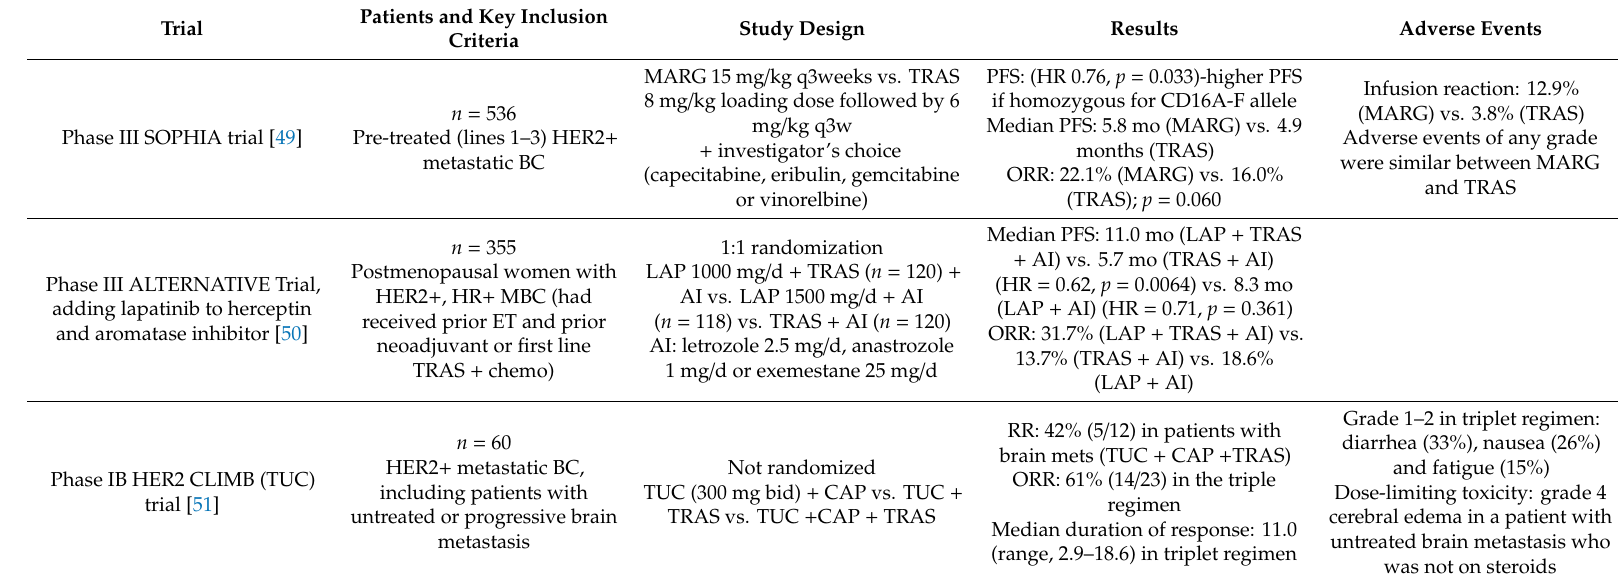
Table 1. Trials of Newer HER2 Targeted